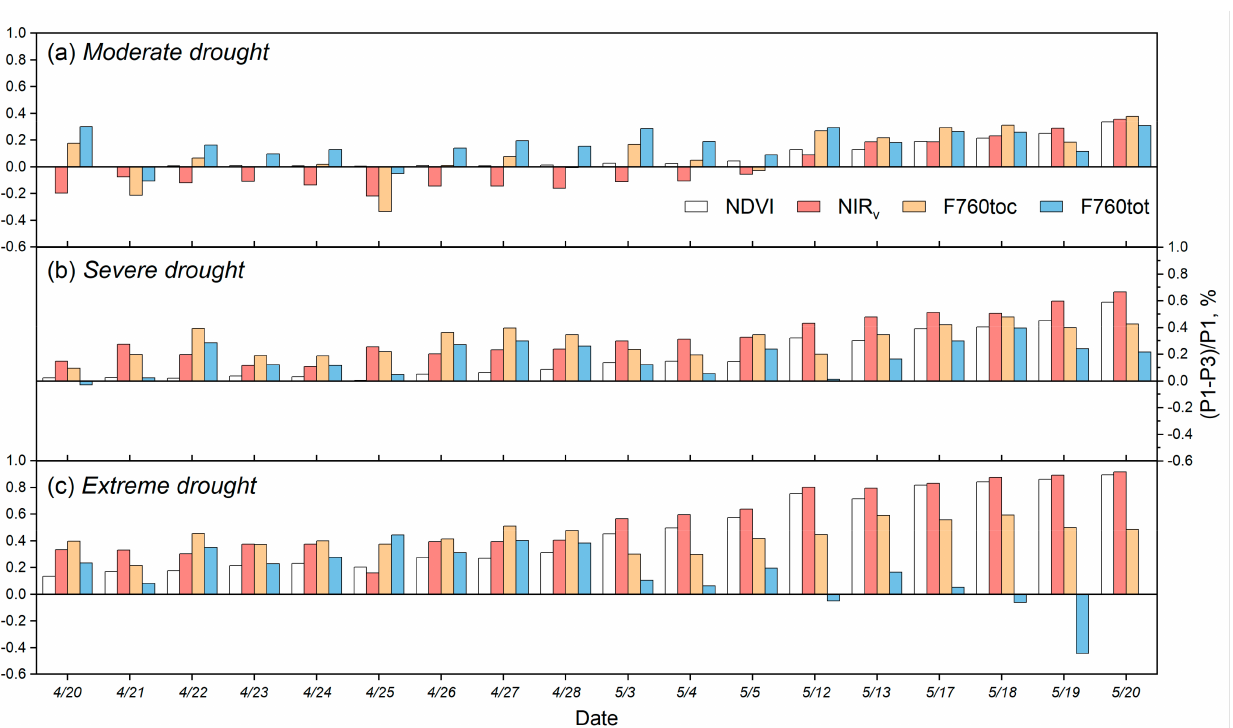
Figure 6. Drought-induced decrease in different variables including NDVI, NIR v , F760toc, and F760tot between P1 and ( a ) P2, ( b ) P3, and ( c )